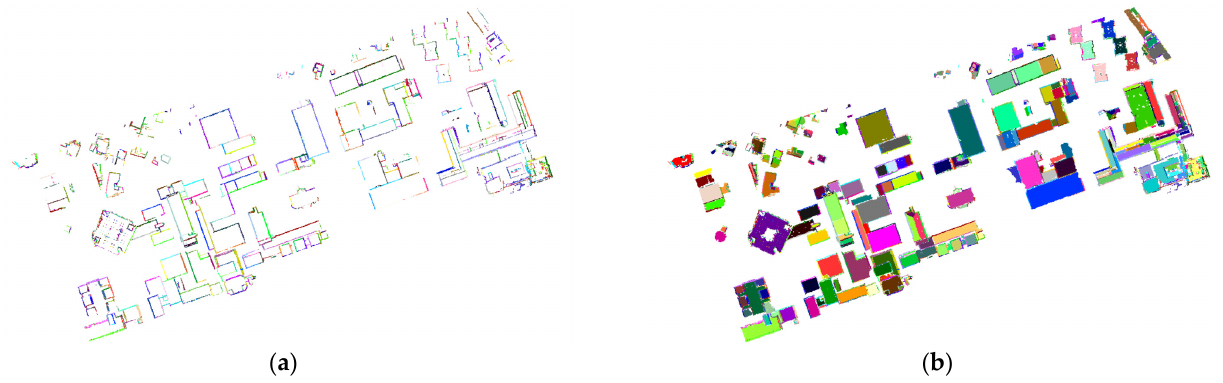
Figure 26. ( a ) The segments representing the façades planes, ( b ) all segments corresponding to the buildings from the study